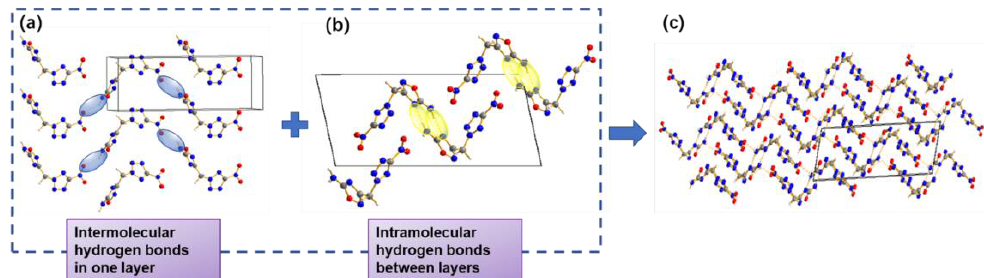
Figure 3. ( a ) Two-dimensional image of NTOM; ( b ) stacking diagram of NTOM; ( c ) two-dimensional image of NTOF; ( d ) stacking diagram of NTOF.